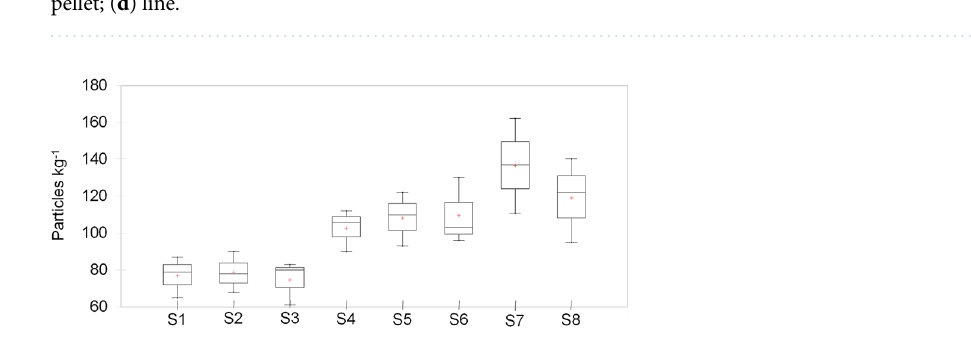
Figure 4. Box plot of MP abundance (particles kg −1 ) for the sampling sites S1 to